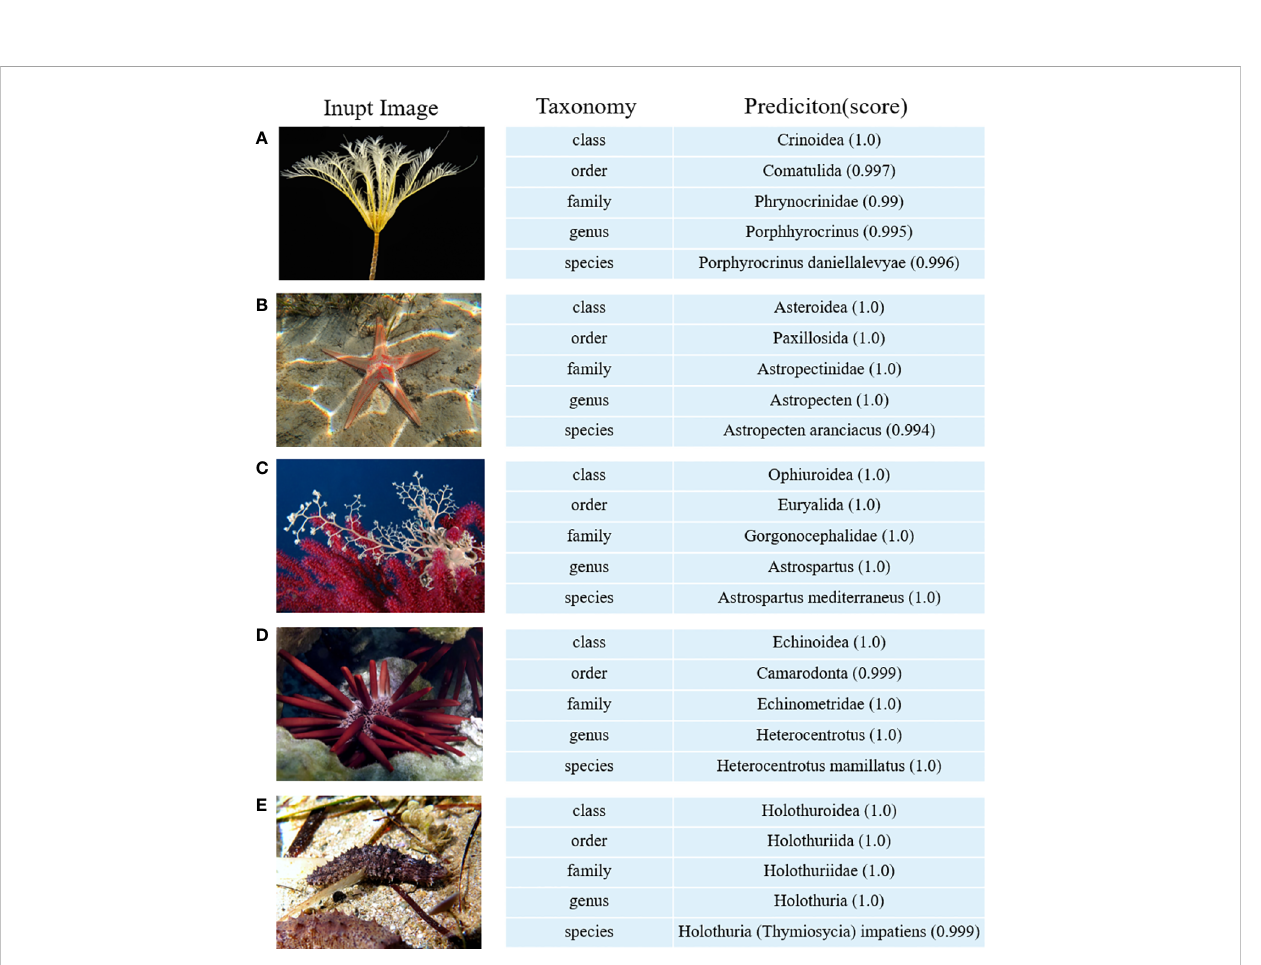
FIGURE 6 Comparison of the original image and Grad-CAM heat map of the Echinoidea image at the fi ve classi fi cation levels. (A) is the original image, (B – F) are Grad-CAM heat maps at the Class, Order, Family, Genus and Species classi fi cation levels, respectively.